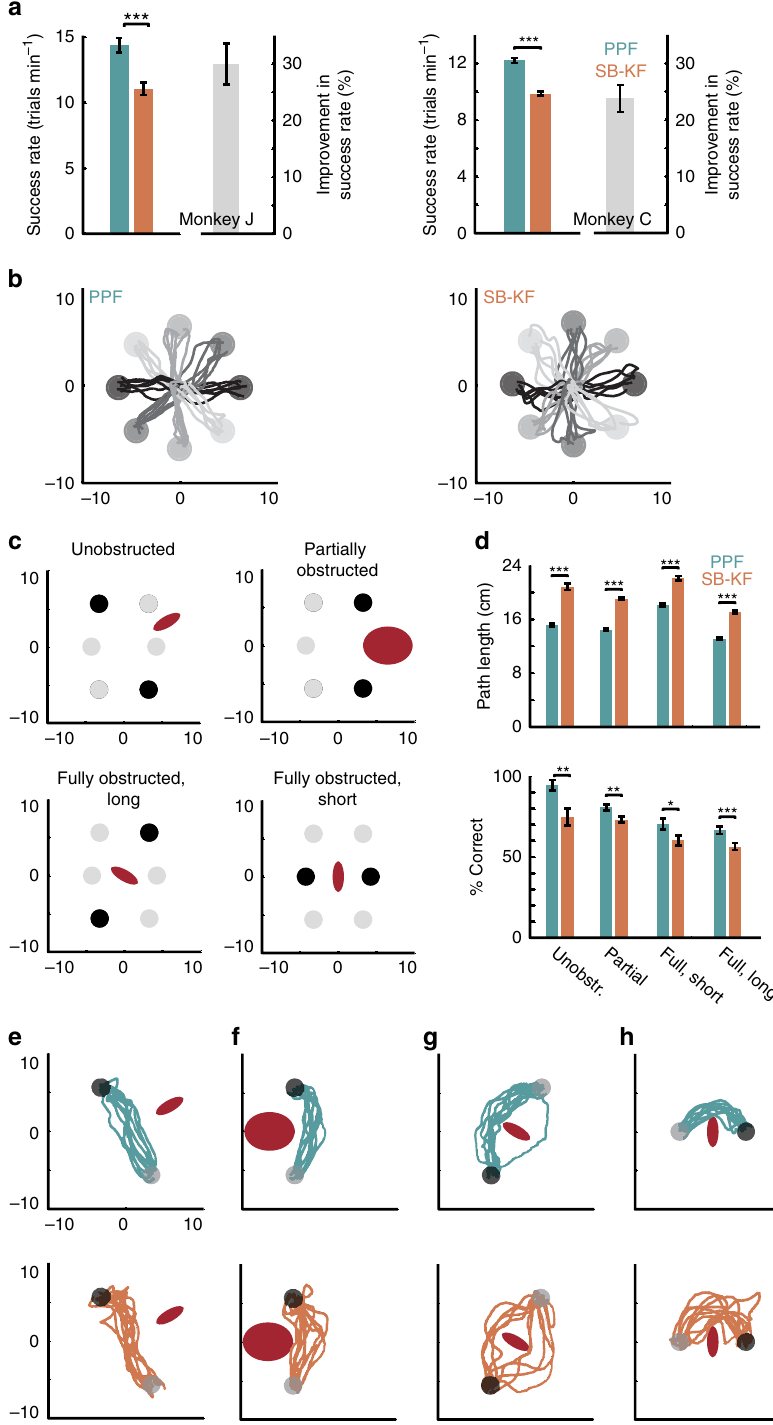
Figure 3 | PPF enhances neuroprosthetic control compared with SB-KF in both monkeys. ( a ) Success rates using PPF and SB-KF on the same days and the corresponding percentage improvement in success rate when using PPF. Stars indicate a significant change with the same convention as in Fig. 2. ( b ) Random PPF and SB-KF centre-out trajectories. ( c ) Multi-curvature obstacle avoidance task. Each trial type consisted of a start target, an end target and an obstacle (red). The trials were constructed to include no obstruction, partial obstruction, full obstruction with a long distance between targets and full obstruction with a short distance between targets. Thus the obstacle avoidance task requires the monkey to perform movements of different lengths, locations and curvatures. ( d ) Comparison of path length and percentage correct (% correct) when monkey J used SB-KF or PPF for each of the four trial types in the obstacle avoidance task. Unobstr., unobstructed. ( e – h ) Sample trajectories (10 randomly selected per figure) using PPF (top) and SB-KF (bottom) for each of the four trial